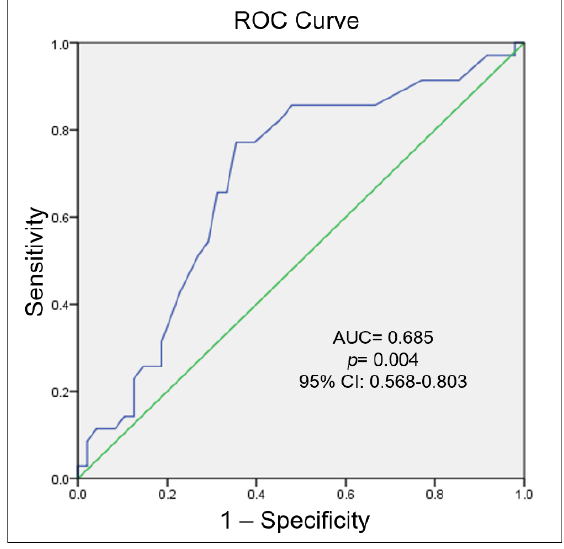
Figure 4 . Receptor-operator characteristic (ROC) curve analysis associated to the presence of septal defects by TBX5 gene methylation level.